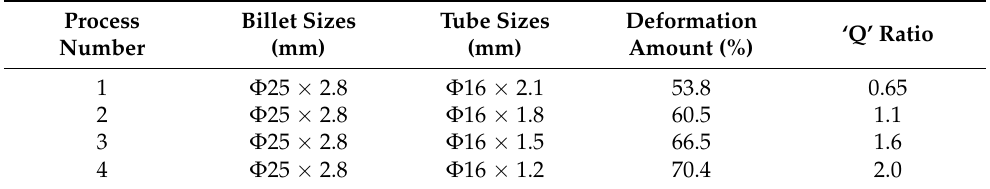
Table 2. Tube sizes, rolling deformation amount ε and ‘Q’ ratio.